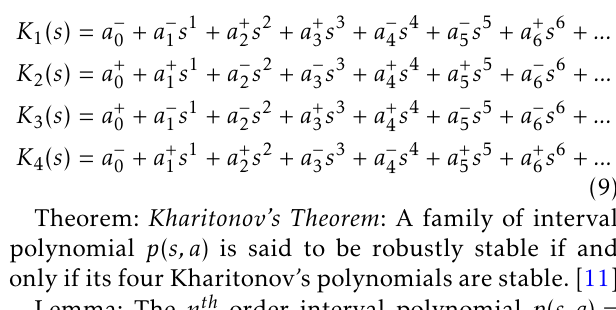
Figure 6. The sub-region of Kp and Ki within the acceptable stabilizing region for ± 25 % uncertainty to obtain peak